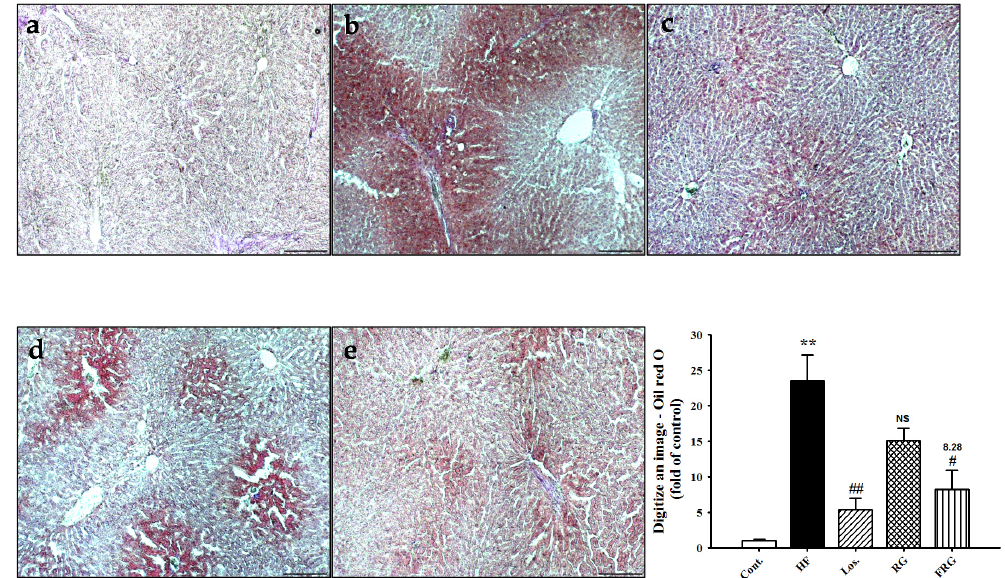
Figure 7. Representative microscopic photographs of Oil red O stained sections of the livers in HF diet rats. Representative Oil red O staining and quantifications are shown (magnification ×100). Values were expressed as mean ± S.E. ( n = 3). ** p < 0.01 versus Cont.; # p < 0.05, ## p < 0.01 versus HF. ( a ) control; ( b ) HF; ( c ) HF + Los.; ( d ) HF + RG (red ginseng); ( e ) HF + FRG (fermented red ginseng).